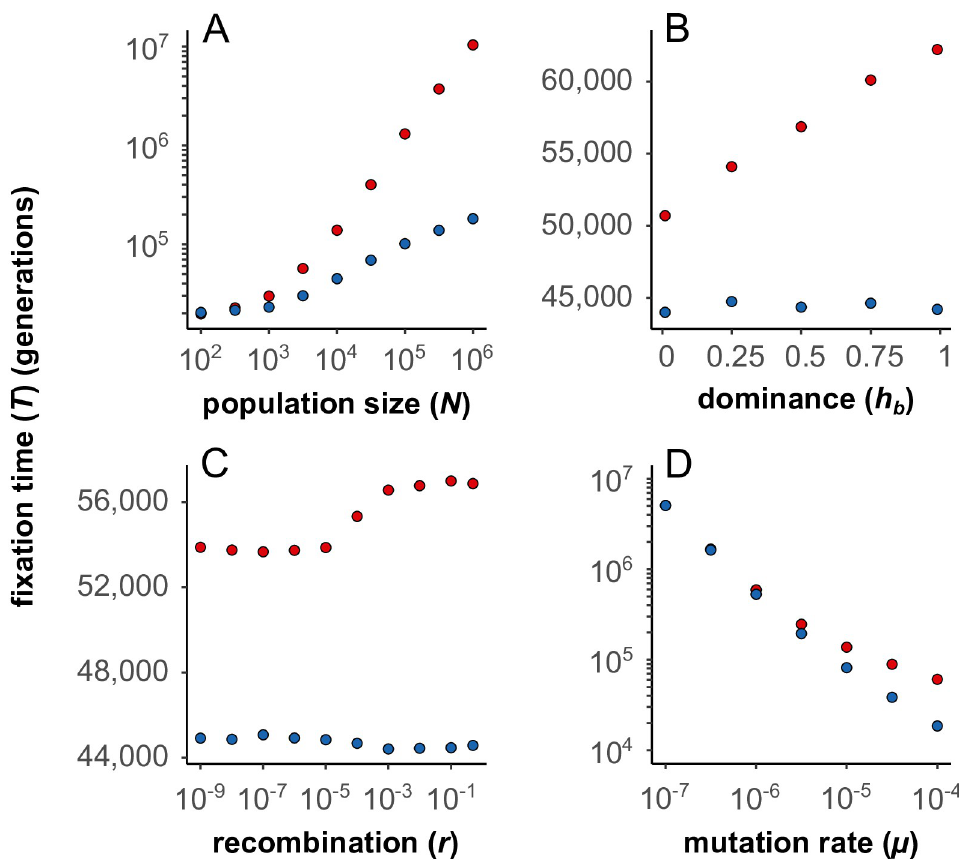
Fig 5. Fixation time of BDMi mutations (red) compared to neutral mutations (blue) in outcrossing populations ( σ = 0) (two-locus model). (A) Higher population sizes (N) decelerate the fixation of BDMi mutations ( s B = 2.5.10 − 2 , h B = 0.5; red) compared to neutral mutations ( s = 0; blue). r = 0.5, μ = 2.5.10 − 5 . 1, 000 iterations. (B) Higher coefficients of b dominance ( h ) decelerate the fixation of BDMi mutations ( s = 2.5.10 − 4 ; red) compared to neutral mutations ( s = 0; b b b blue). N = 10, 000, r = 0.5, μ = 2.5.10 − 5 . 10, 000 iterations. (C) Higher rates of recombination ( r ) decelerate the fixation of = 2.5.10 − 4 , h = 0.5; red) compared to neutral mutations ( s = 0; blue). N = 10, 000, μ = 2.5.10 − 5 . 100, BDMi mutations ( s b b b 000 iterations. (D) Higher rates of mutation ( μ ) decelerate the fixation of BDMi mutations ( s b = 2.5.10 − 3 , h b = 0.5; red) = 0; blue). N = 10, 000, r = 0.5. 10, 000 compared to neutral mutations ( s b